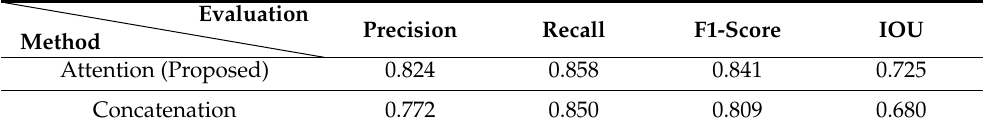
Table 6. Performance between model with attention and with concatenation.